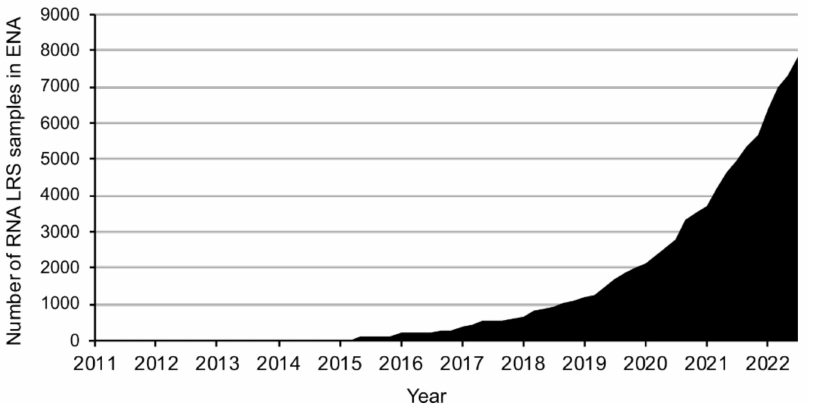
Figure 1. The number of publicly available long-read RNA sequencing datasets has been increas- ing at an exponential rate. Total number of long-read RNA sequencing samples deposited in the European Nucleotide Archive (ENA) over time. Sample selection criteria were (i) RNA sequenc- ing, (ii) sequenced on an Oxford Nanopore or a PacBio machine, and (iii) containing more than 100,000